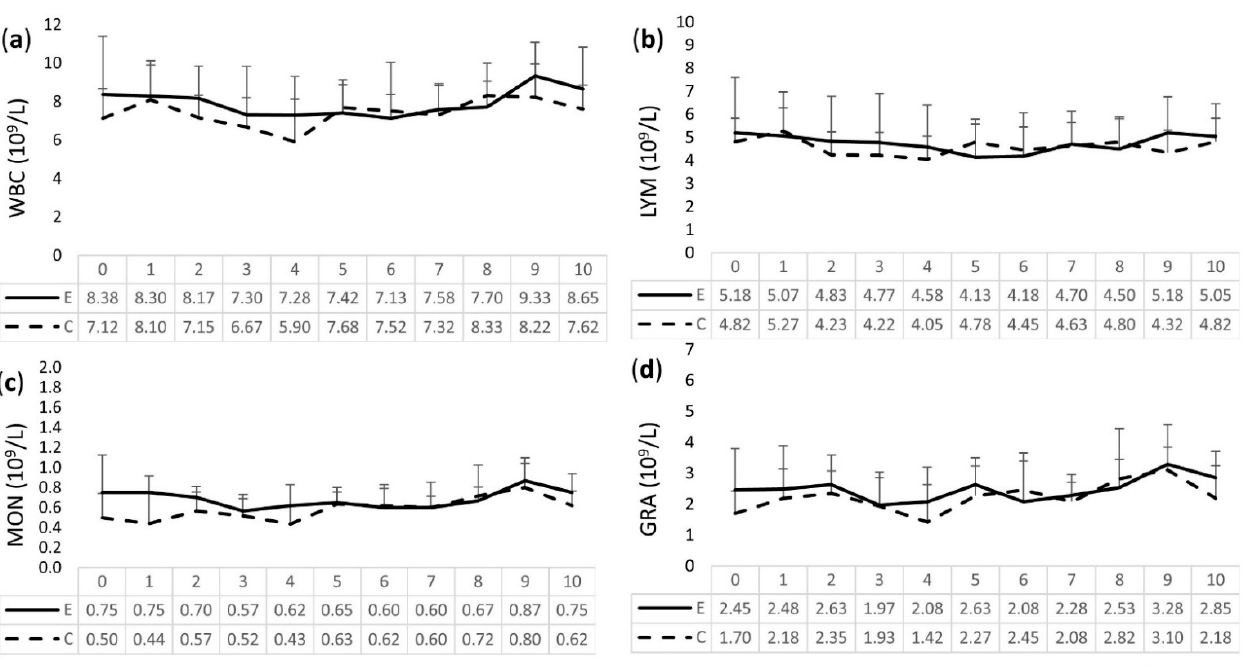
Figure 1. Results of examination of white blood cells (WBC) and its differentiation: ( a ) WBC; ( b ) lymphocytes (LYM); ( c ) monocytes (MON); ( d ) granulocytes (GRA), in the peripheral blood of experimental (E) and control (C) calves.